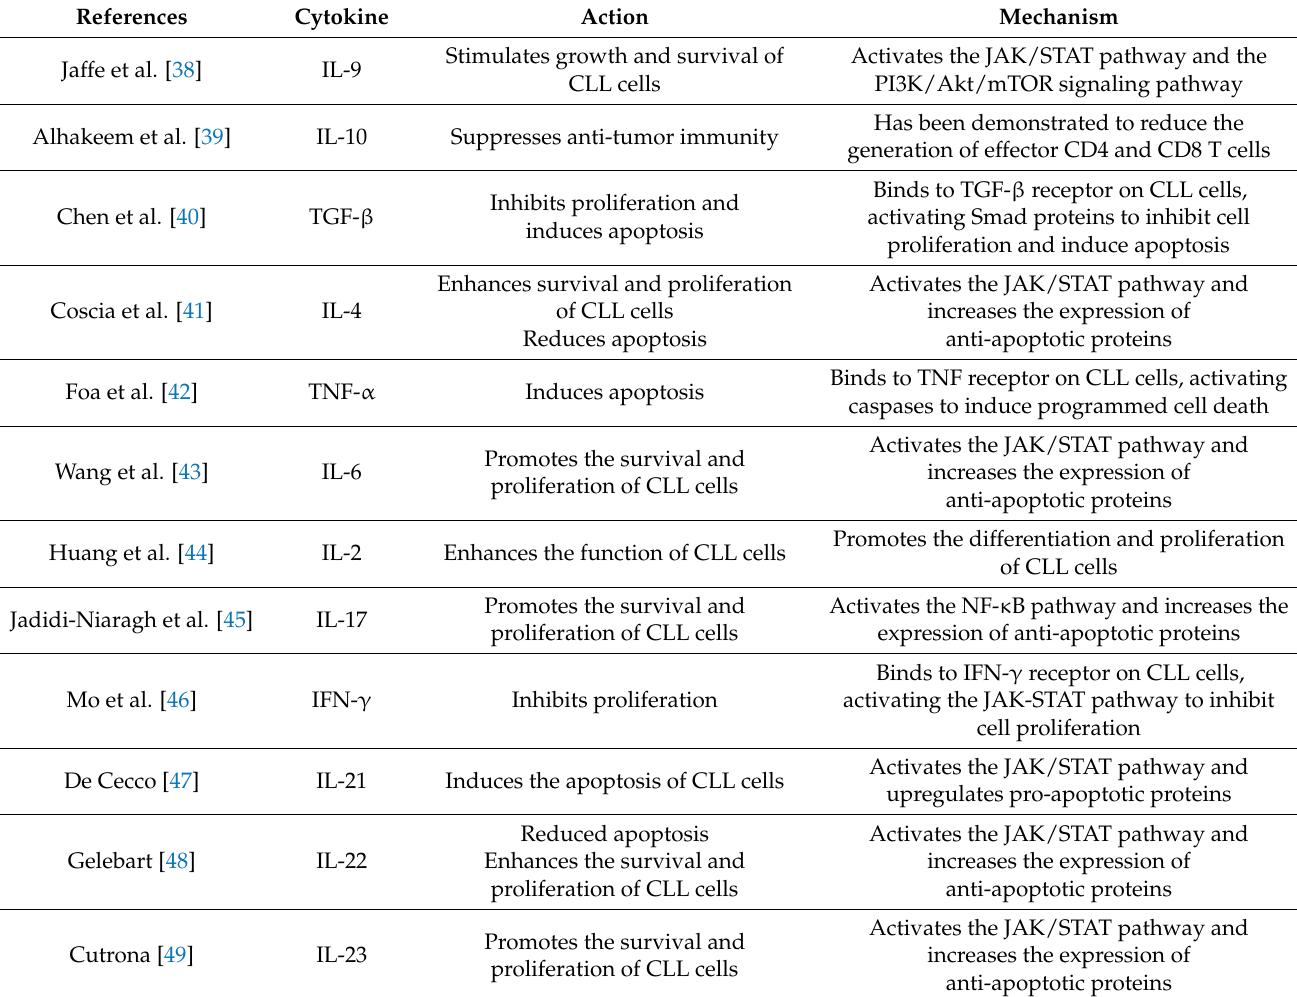
Table 1. Role of different cytokines in CLL and their mechanism of